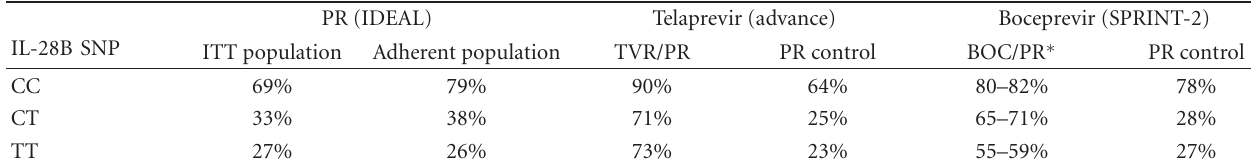
Table 2: Role of IL-28B in HCV